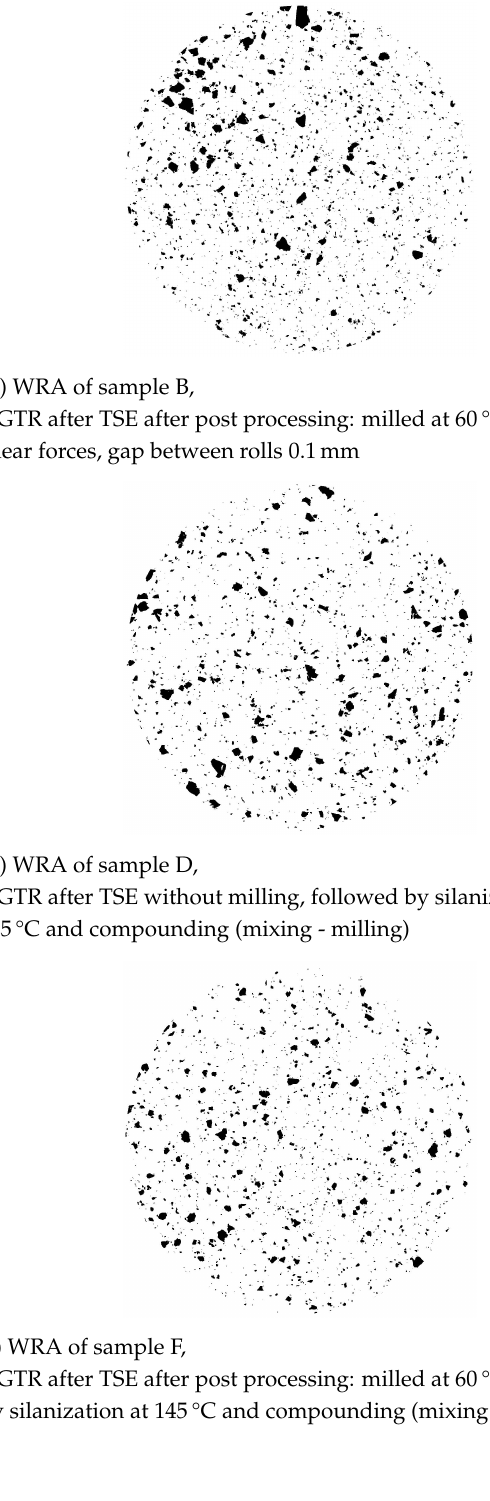
Figure 13. Influence of post processing on size and amount of visible grains in DGTR by WRA. The diameter of the samples is